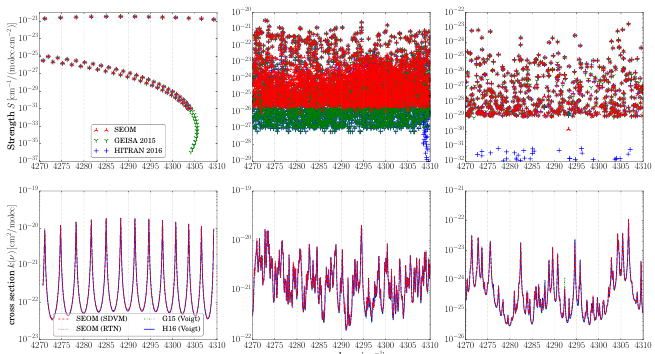
Figure 1. (Top) Line strengths S of CO (left), CH 4 (center), and H 2 O (right) for the three databases in Table 1. While the strong lines are similar in all databases the values do not agree completely. (Bottom) Cross sections of the three molecules at reference pressure (1013.25hPa) and temperature